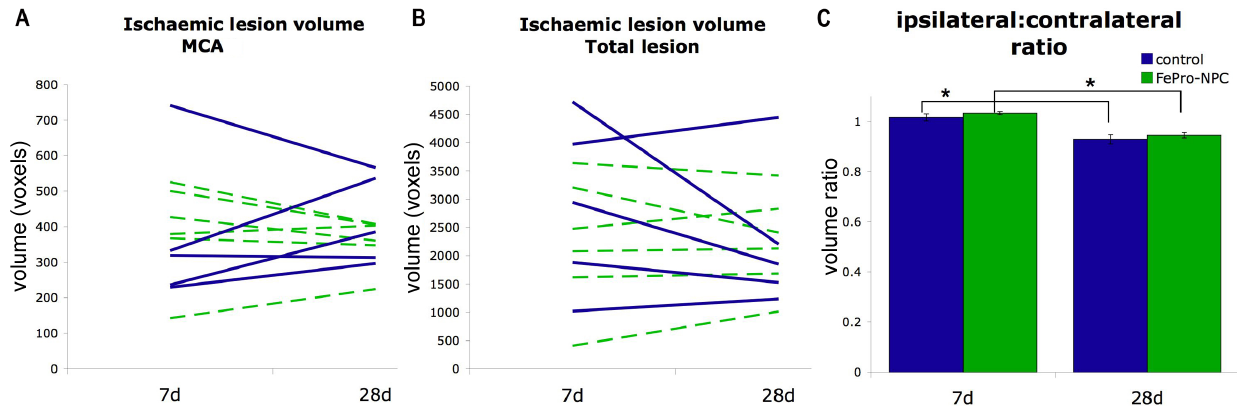
Figure 7. Analysis of lesion volume change 7 days and 28 days after MCAO in FePro-NPC grafted and controls. A , Lesion volume (cm 3 /mL) of the central MCA region slice. There is no significant difference between controls (solid line, blue) and FePro-NPC (dashed line, green) lesion volumes at the MCA region (p=0.577). B , Total lesion volume. There is no significant difference between control and FePro- NPC lesion volumes (p=0.921). C , Hemisphere volume change. Change in ipsilateral:contralateral hemisphere volume ratio between 7 and 28 days (*:ANOVA, p<0.0001), but there is no significant difference between control and FePro-NPC in hemisphere